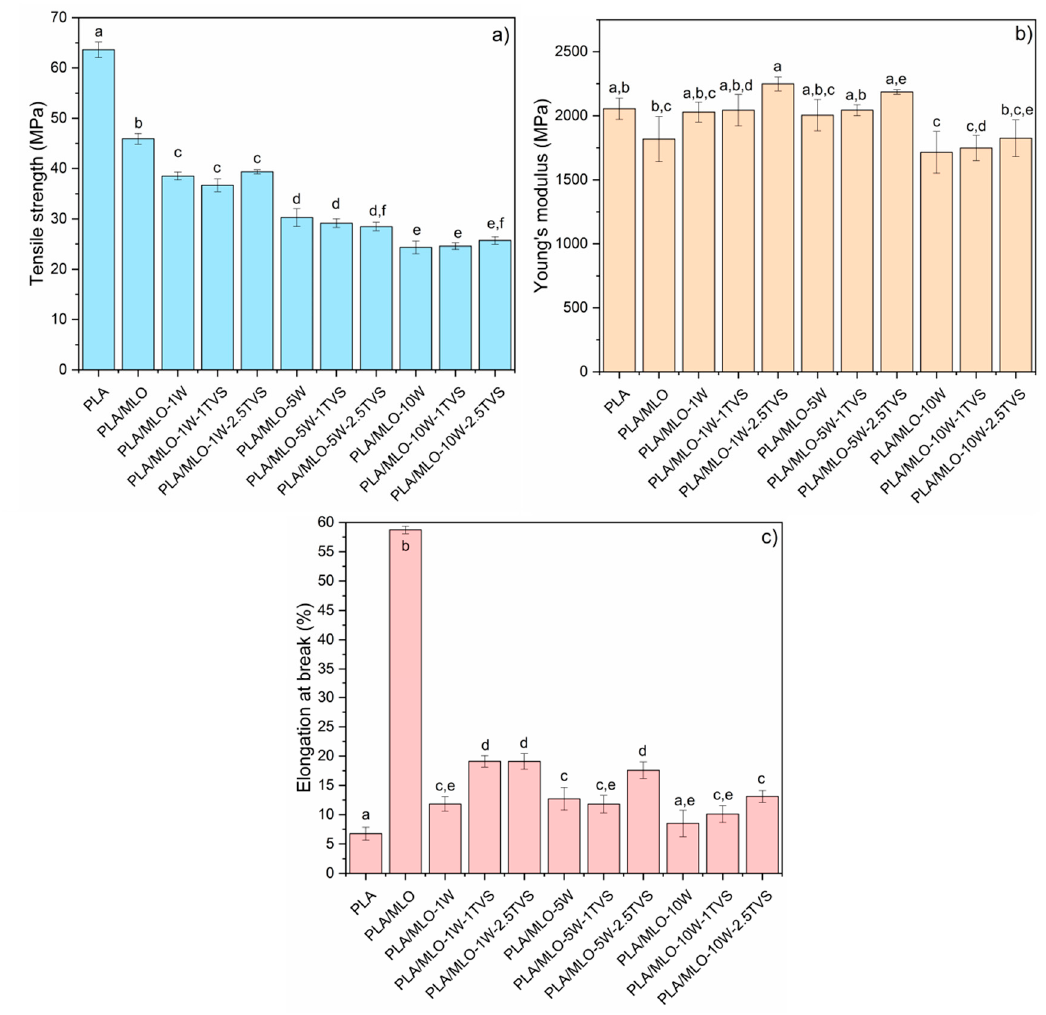
Figure 6. Tensile test results: ( a ) tensile strength, ( b ) Young’s modulus, and ( c ) elongation at break. a–f Different letters within the same property show statistically significant differences between formulations ( p < 0.05).